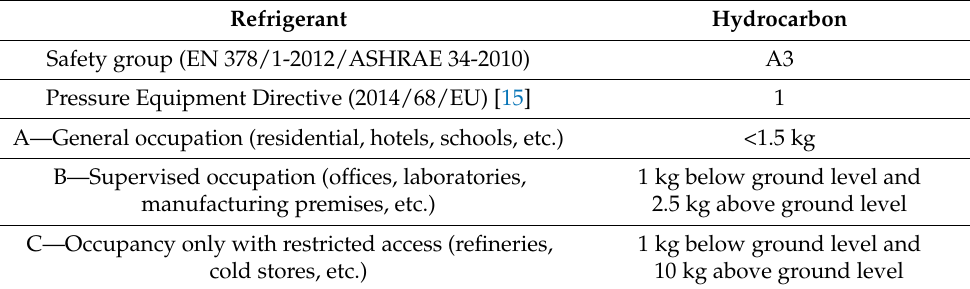
Table 1. Authorized charge in type A, B and C premises for direct